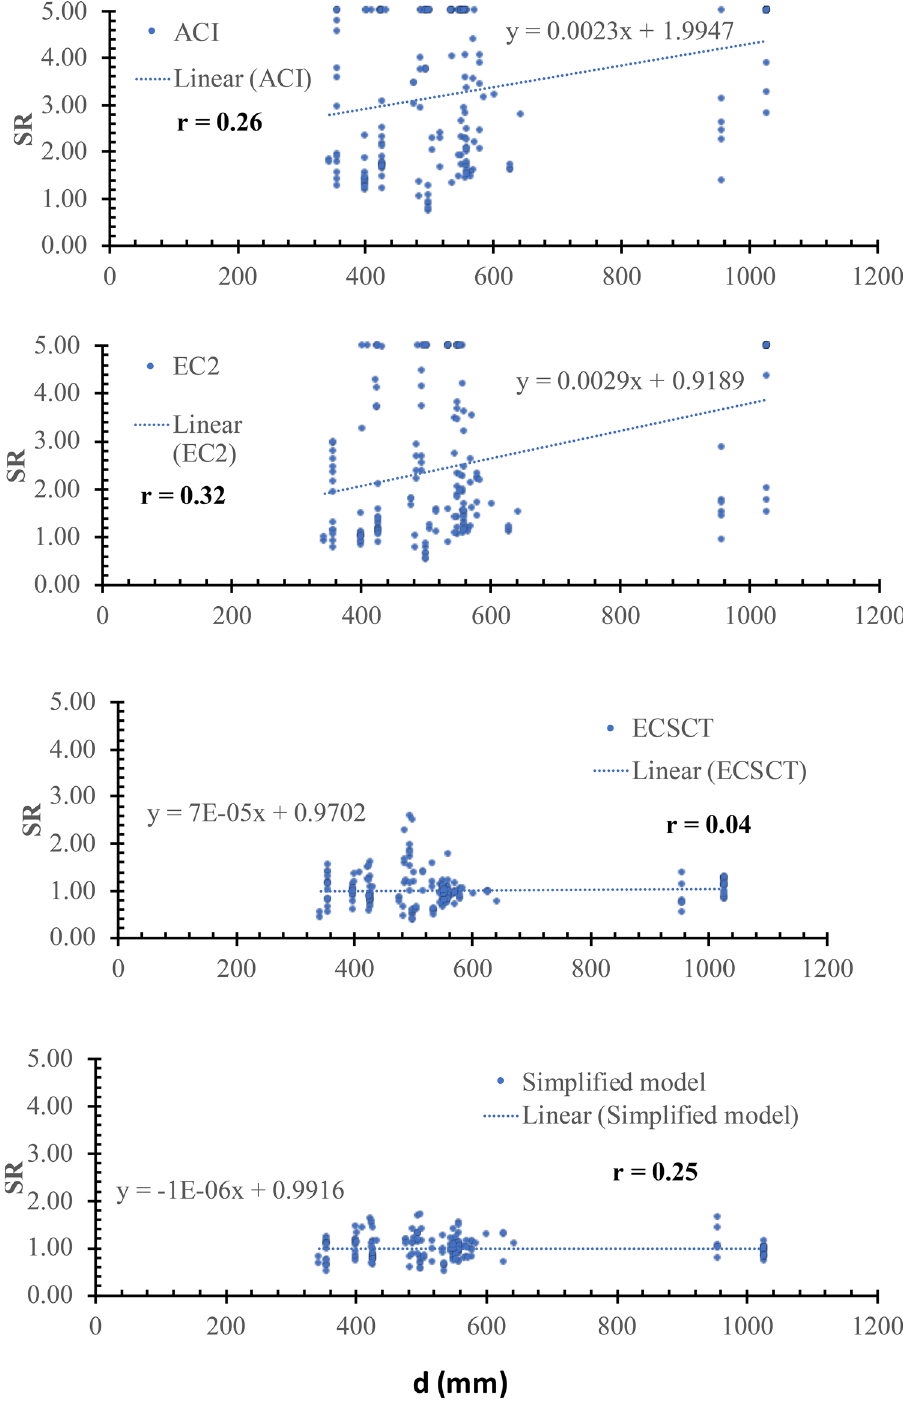
Figure 12. SR using various methods versus the a / d